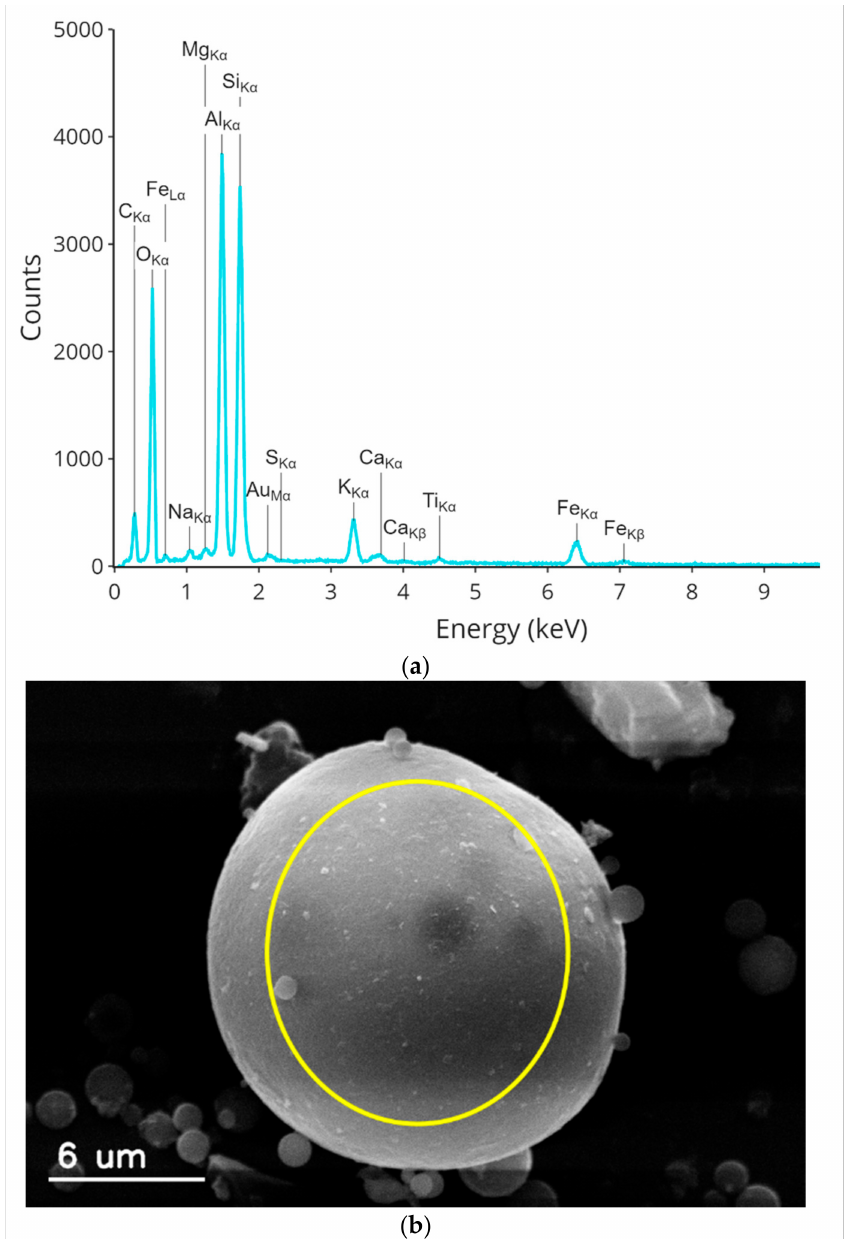
Figure 5. ( a ) EDS spectrum of a nonmagnetic particle; ( b ) SEM microphotograph with circle showing the area the spectrum